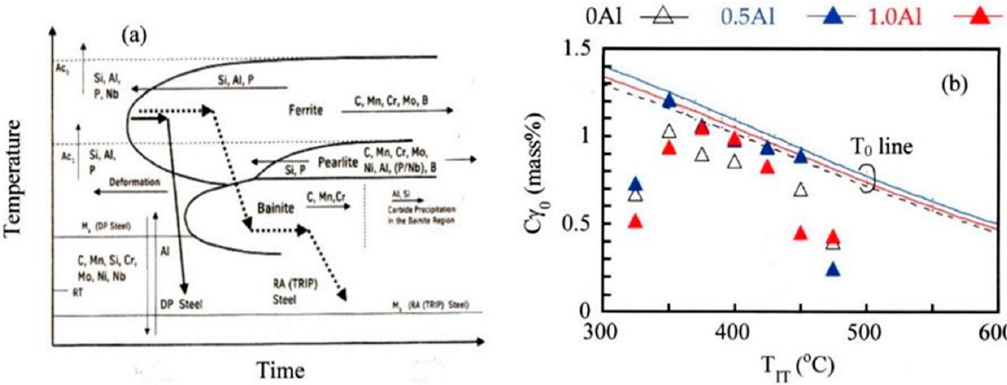
Figure 7. ( a ) Effects of microalloying elements on the time-temperature transformation curve of steel [90]. ( b ) Calculated T 0 curves and measured carbon concentration of retained austenite ( C γ 0 ) on 19C-1.54Si-1.51Mn-0.04Al (0Al), 0.5Al: 0.20C-0.99Si-1.51Mn-0.49Al (0.5Al), and 0.20C-0.49Si-1.50Mn- 0.99Al (1.0Al) TPF steels [75]. ( a ) is reprinted with permission from AIST, copyright 2022. ( b ) is reproduced with permission from ISIJ, copyright 2022.